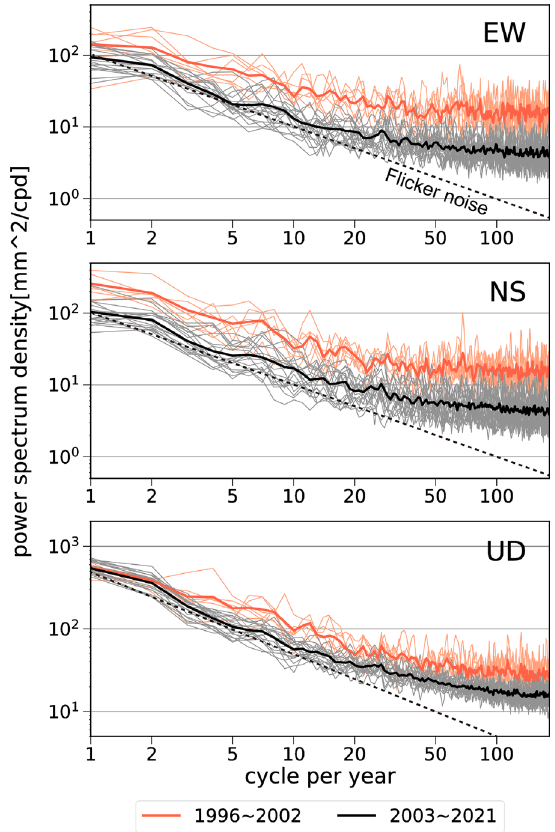
Fig. 6 Power spectra for the station coordinates derived from F5 RSA. The power spectra in 365 days were stacked over the stations. The thin red and black lines indicate the individual spectrum in 1996 through 2003 and 2003 through 2020, respectively. The thick red and black lines indicate the stacked spectrum over 1996 through 2003 and 2003 through 2020, respectively. The dashed line in each panel indicates the gradient of the flicker noise as a